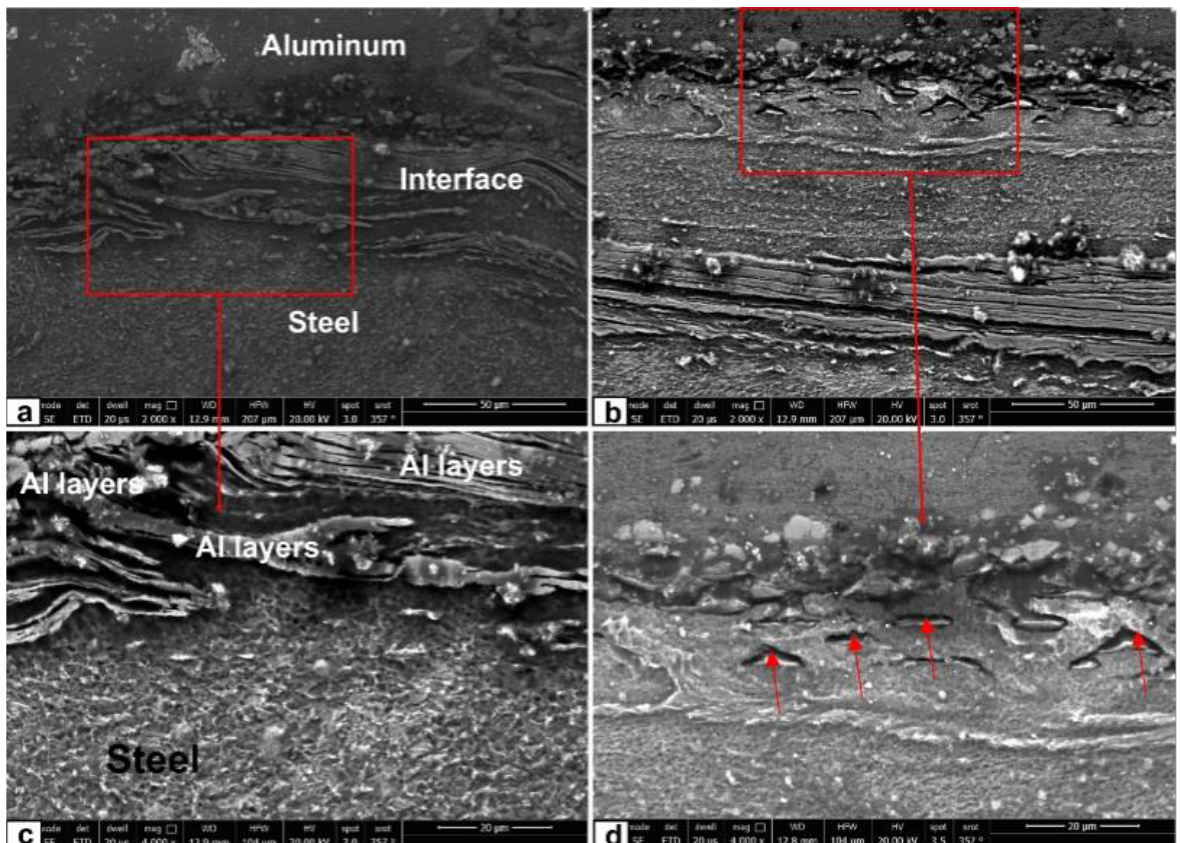
Figure 4. SEM Micrographs of the aluminum/steel interface produced with high FSP rotation speed of 1500 rpm and pin length of 3 mm: ( a ) steel – aluminum interface, ( b ) the interface ’s upper side, ( c ) the zoomed-in area of ( a ), and ( d ) the zoomed-in area of ( b ).